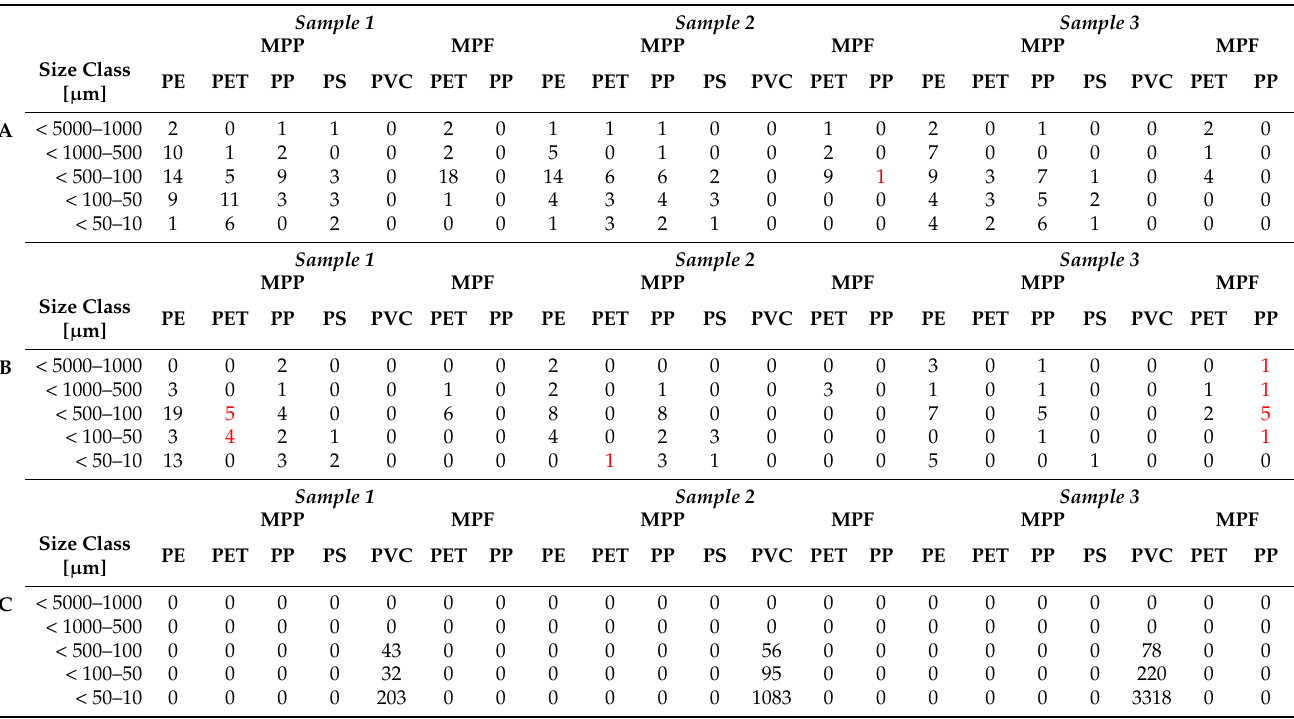
Table A2. Non-extrapolated numbers of MPP and MPF identified in the sand filter influent of each sample of the Mannheim WWTP (A), the Frankfurt Sindlingen WWTP (B), and the PVC manufacturer’s plant (C).